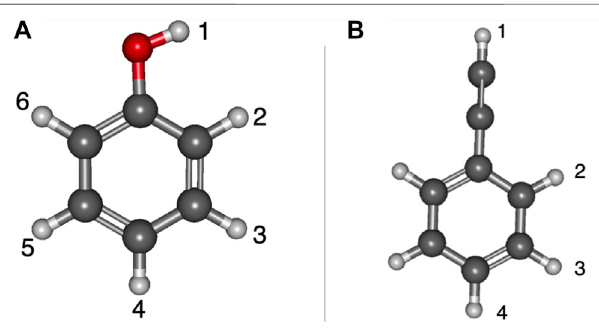
labeled in Figure 1 . The deprotonation sites correspond to the fi rst column of the tables throughout the paper. For instance, in Table 1 , phenol radical/anion 1 is the removal of the hydrogen on the oxygen atom.